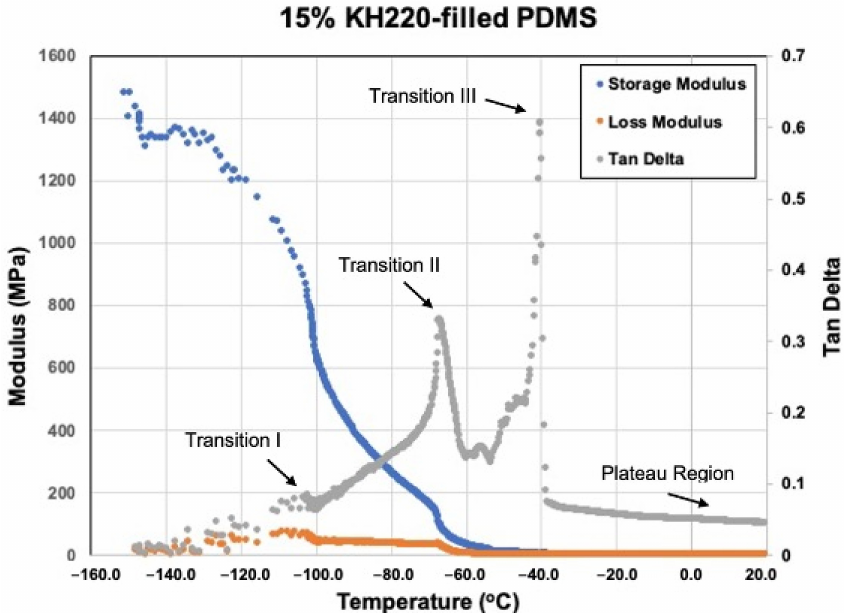
Figure 17. Storage Modulus, Loss Modulus, And Tan Delta Curves For 15% KH220-filled PDMS From − 150 ◦ C To +20 ◦